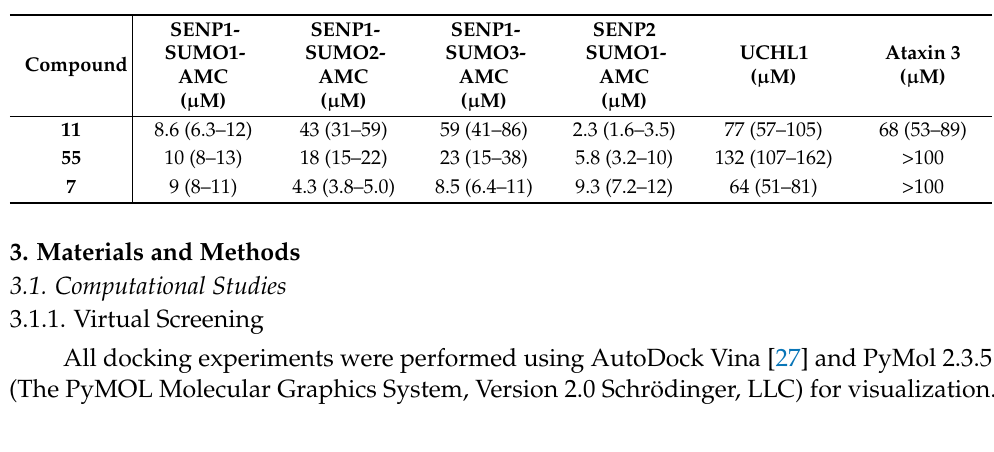
Table 4. IC 50 values of 11 (ZHAWOC8697), 55 and published compound 7 [21] ; n =